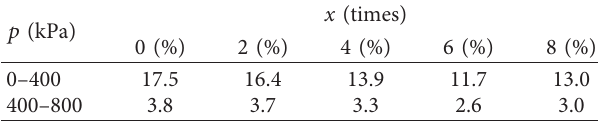
Table 3: Reduction of the void ratio.